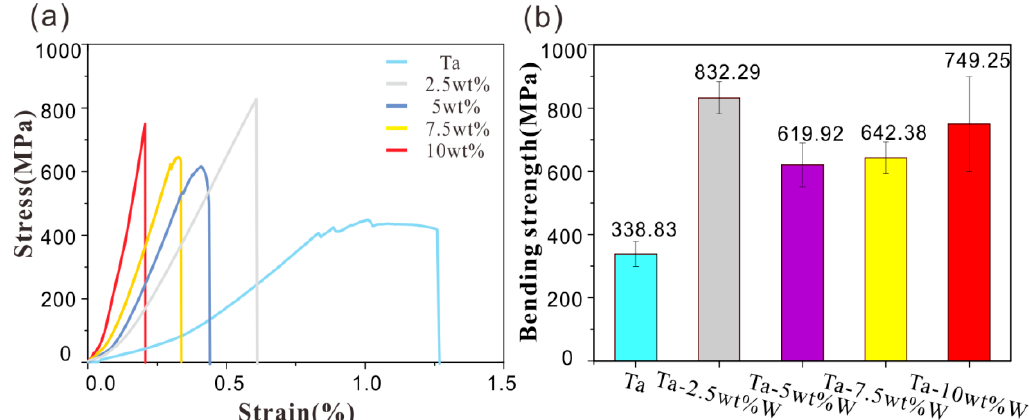
Figure 8. The flexural stress-strain curve ( a ) and ultimate flexural strength ( b ) of tantalum tungsten alloy with different tungsten contents.